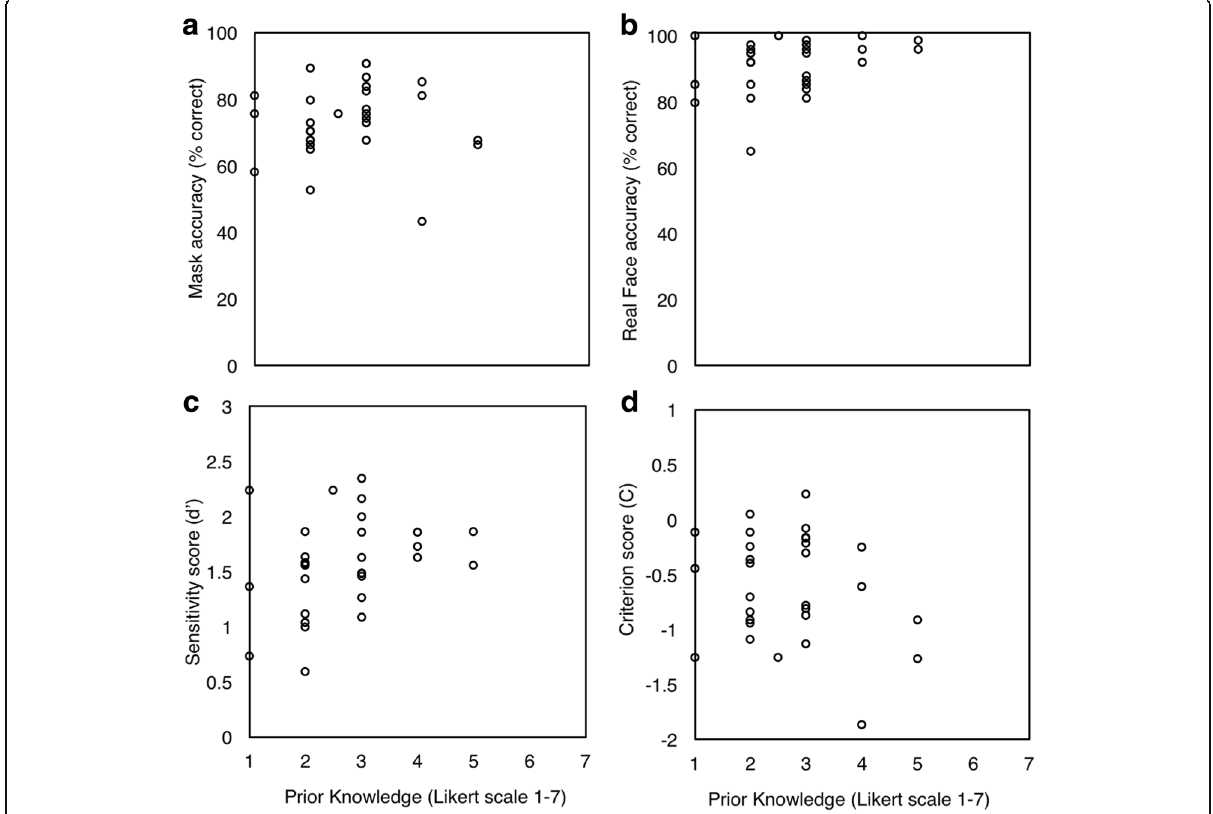
Fig. 8 Scatterplots showing participants ’ mean categorization accuracy rates for high-realism masks ( a ) and real faces ( b ), discriminability ( c ) and bias ( d ) as a function of prior mask knowledge in Study